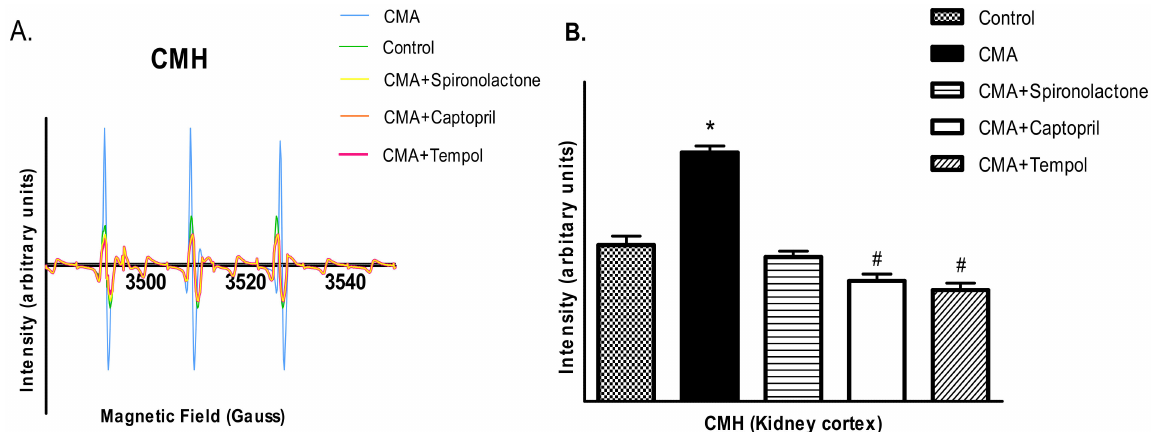
Figure 11. Electron paramagnetic resonance (EPR) analysis for the detection of superoxide and peroxynitrite free radicals. ( A , B ) show the EPR signal intensities and relative EPR signal area quantification (arbitrary units), respectively, for superoxide radicals.